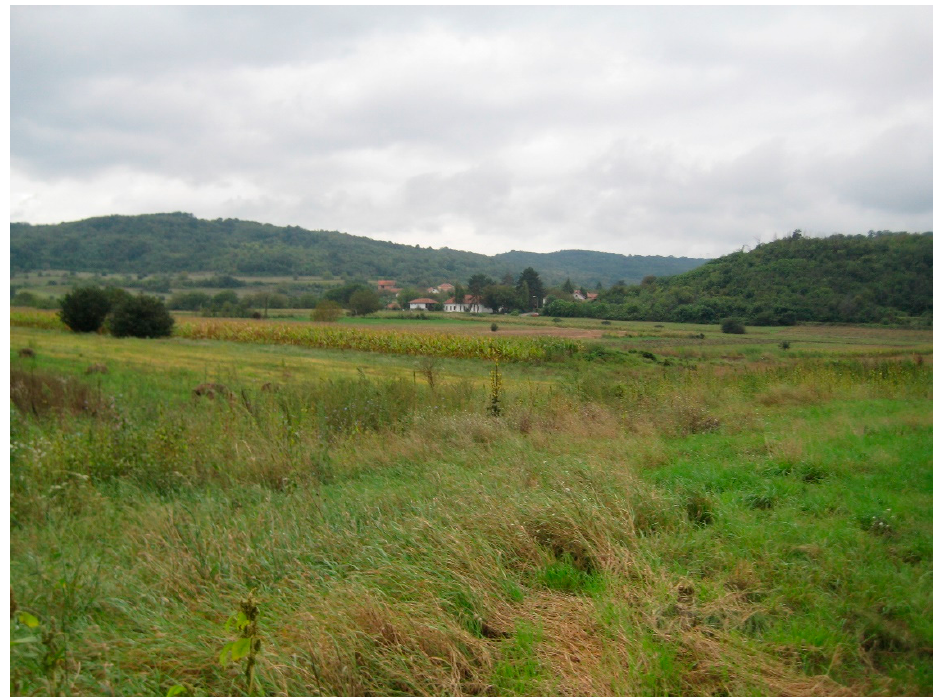
Figure 6. View from the military camp to the west and southwest: Civilian settlement and necropolises (photo by L. Diers).